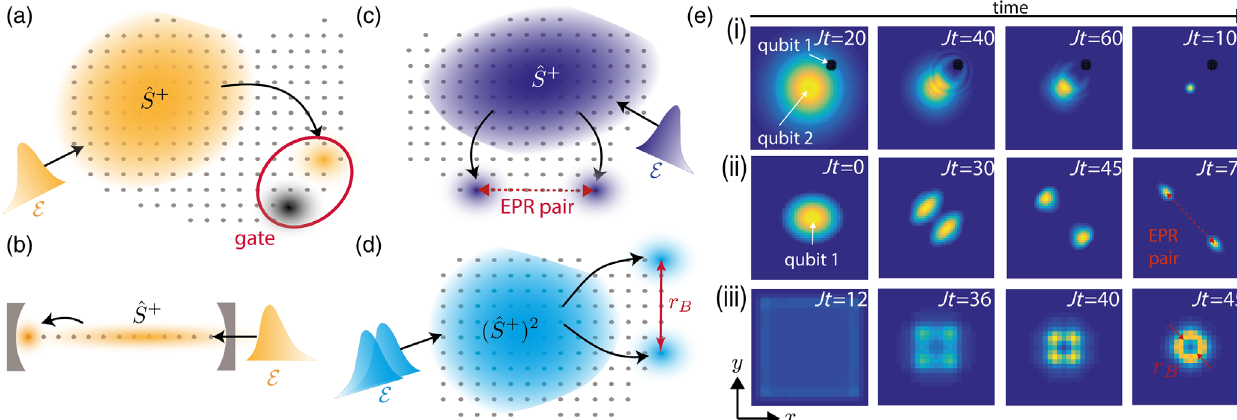
FIG. 1. (a) – (d) Various scenarios of a quantum light-atom interface illustrating a quantum spin lens. Incident photonic qubits are initially stored as delocalized spin excitations in an atomic array, and focused to single atoms (see Sec. II). (a) Basic process of write and focusing operations (see Secs. II A and II B). Qubits stored in single atoms allow quantum gate operations to be implemented between adjacent atoms, e.g., via Rydberg gates. (b) 1D setup with atomic ensemble stored inside a cavity (see Sec. II D). (c) Generation of EPR- type states by constructing lenses with multiple focal points (see Sec. II C). (d) Focusing dynamics with a nonlinear spin lens with repulsive spin-spin interactions with range r , illustrated for two spin excitations (see Sec. III). (e) Density plots illustrating focusing B dynamics of spin excitations in 2D arrays as a function of time t according to spin-lens Hamiltonians Eqs. (1) or (10). (i) Focusing of an initially delocalized “ qubit 2 ” in the presence of a hole (representing, e.g., a previously stored “ qubit 1 ” ) (see Sec. II). (ii) Two-focus lens illustrating generation of EPR pairs (see Sec. IIC). Parameters: 50 × 50 lattice, initial width of the Gaussian wave packet σ 0 ¼ 10 a lattice spacings. (iii) Focusing of two spin excitations with a nonlinear quantum lens with repulsive spin-spin interactions of range r . B The two excitations are focused to a ring, reminiscent of a quantum crystal. Parameters: 31 × 31 lattice (see Sec.